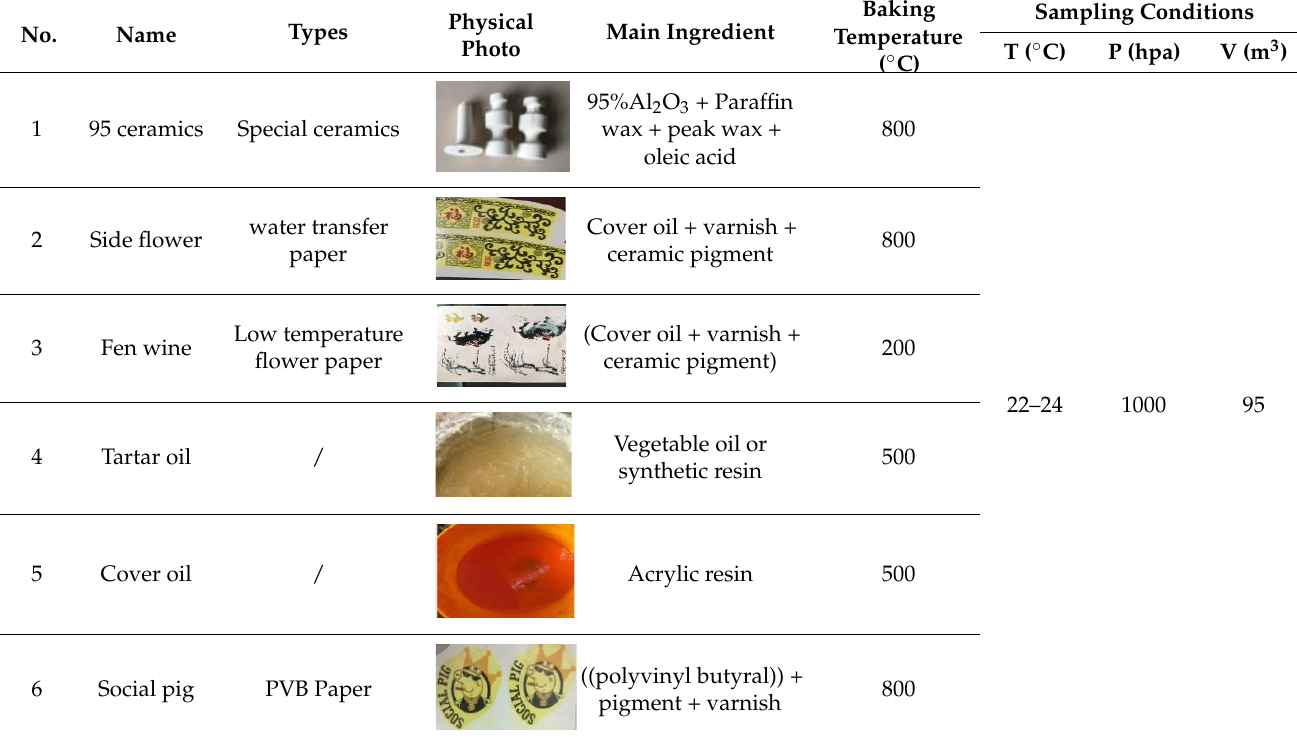
Table 1. Test sample types and sampling conditions of roasted flower and waxing.